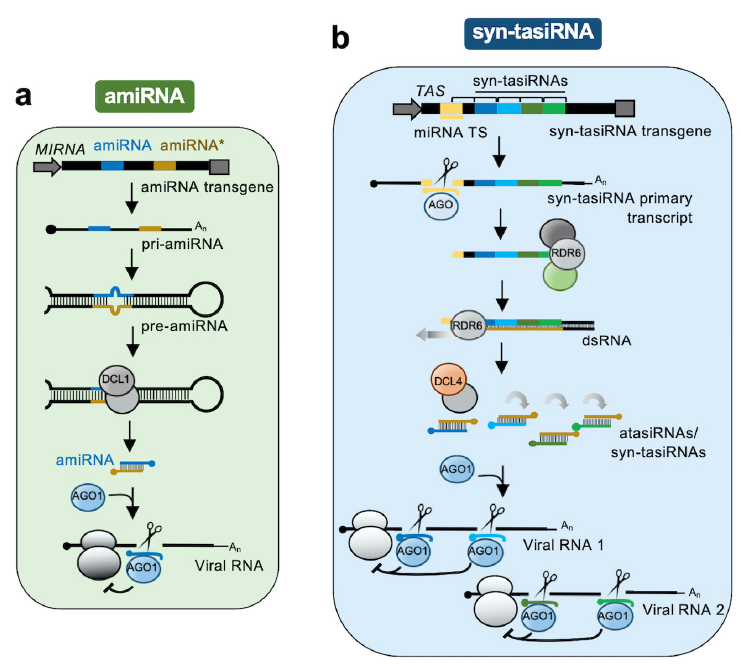
Figure 1. Antiviral art-sRNA pathways in plants. ( a ) The antiviral amiRNA pathway. The amiRNA transgene expresses a monocistronic MIRNA precursor sequentially processed into an amiRNA targeting a single site in a single viral RNA. ( b ) The antiviral syn-tasiRNA pathway. The syn-tasiRNA transgene expressesapolycistronic TAS precursorsequentiallyprocessedintofourdi ff erentsyn-tasiRNAstargeting multiple sites in multiple viral RNAs. Both amiRNA and syn-tasiRNA guide strands associated with AGO1 to silence viral RNAs through endonucleolytic cleavage or translational inhibition.